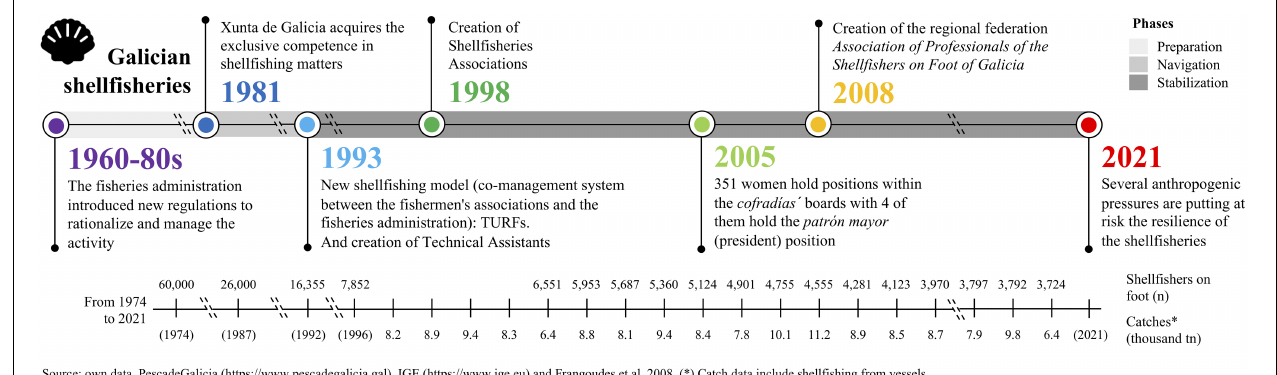
FIGURE 8 | Main landmarks of shellfishing in Galicia from 1960 to